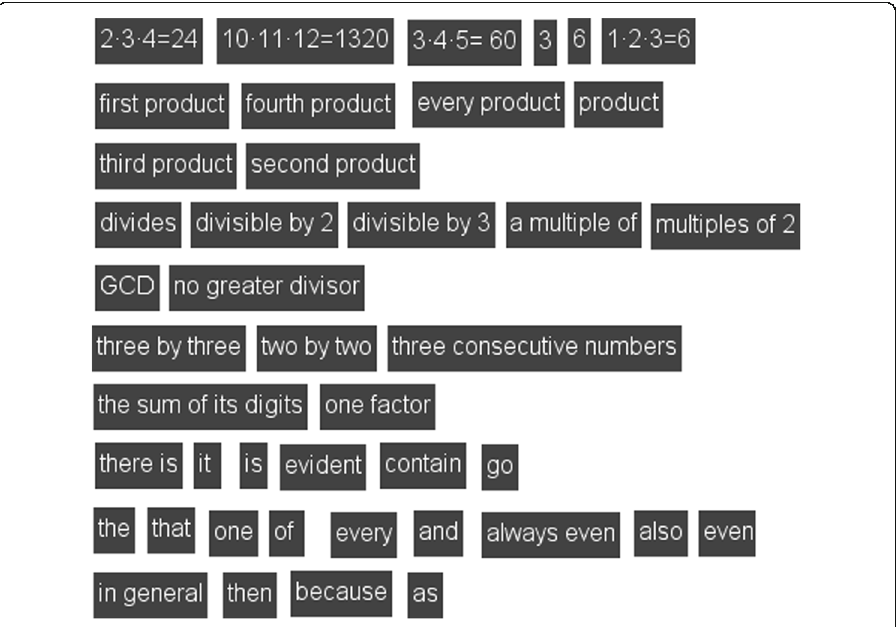
Fig. 4 Language tiles in Albano, Dello Iacono, Mariotti (2019)